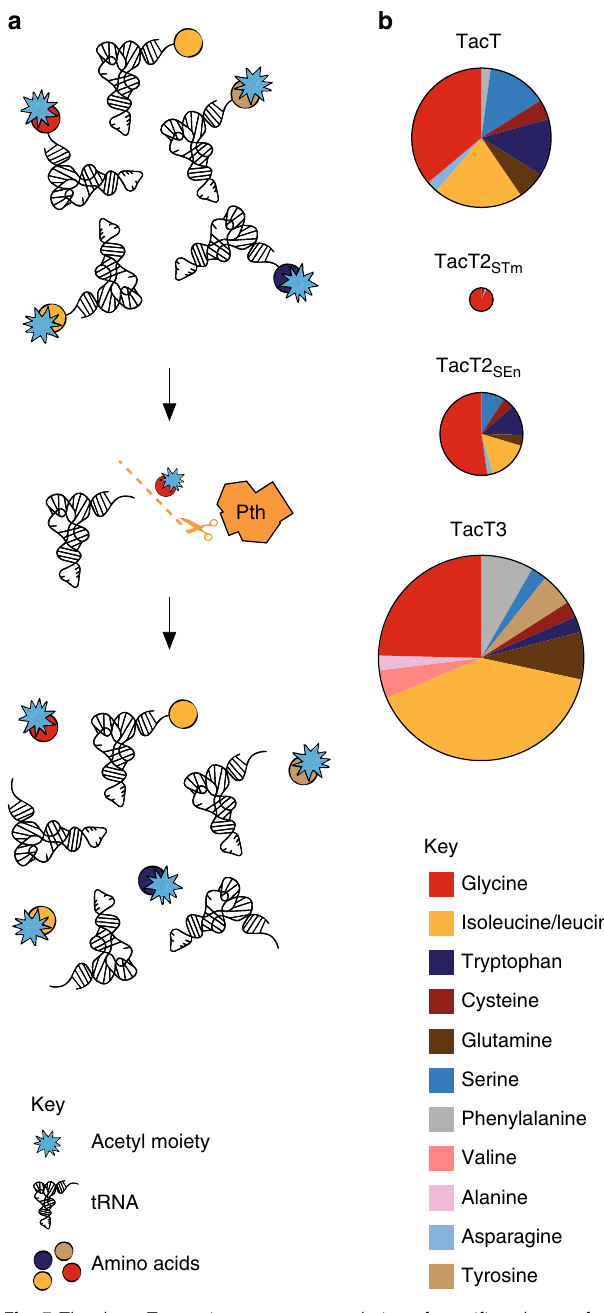
Fig. 5 The three Tac toxins promote acetylation of speci fi c subsets of aa- tRNAs identi fi cation of amino acids acetylated by the different toxins. a Toxin-corrupted aminoacyl-tRNAs were extracted from cell-free expression assays, and treated with puri fi ed Pth to release the acetylated amino acids from tRNAs and subsequently analysed by LC-MS. b Speci fi city of TacT, TacT2 SEn , TacT2 STm and TacT3. Size of pie represents the relative amounts of acetylated amino acids